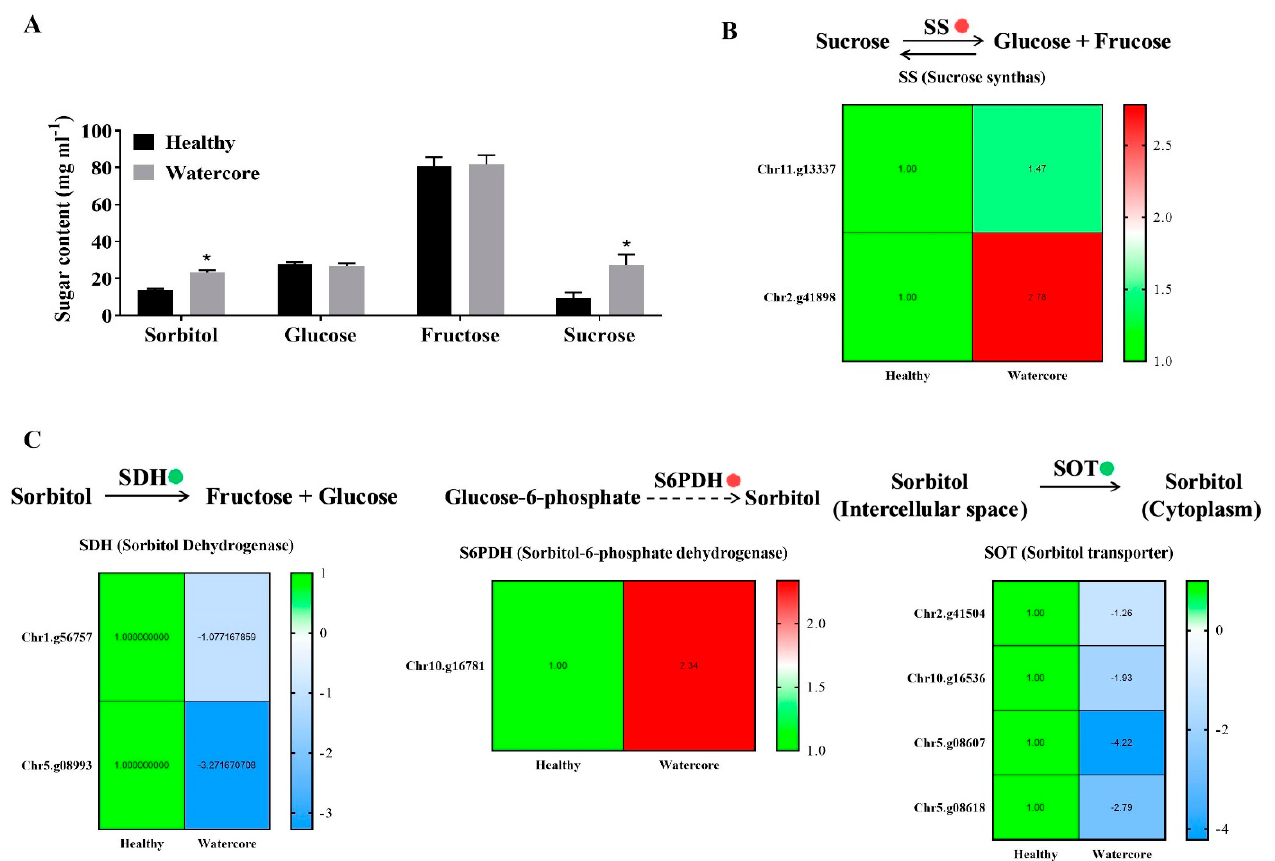
Figure 2. Changes of sugar components’ contents and their metabolism-related gene expression in watercore fruit. ( A ) Changes of sugar components’ contents; ( B ) Changes of sucrose synthas genes expression; ( C ) Changes of sorbitol degradation, synthesis and transport genes expression. The red and green circles refer to up- and down-regulation of gene expression, respectively. * The asterisk on the bars indicates significant differences between the watercore and healthy fruit at p < 0.05.